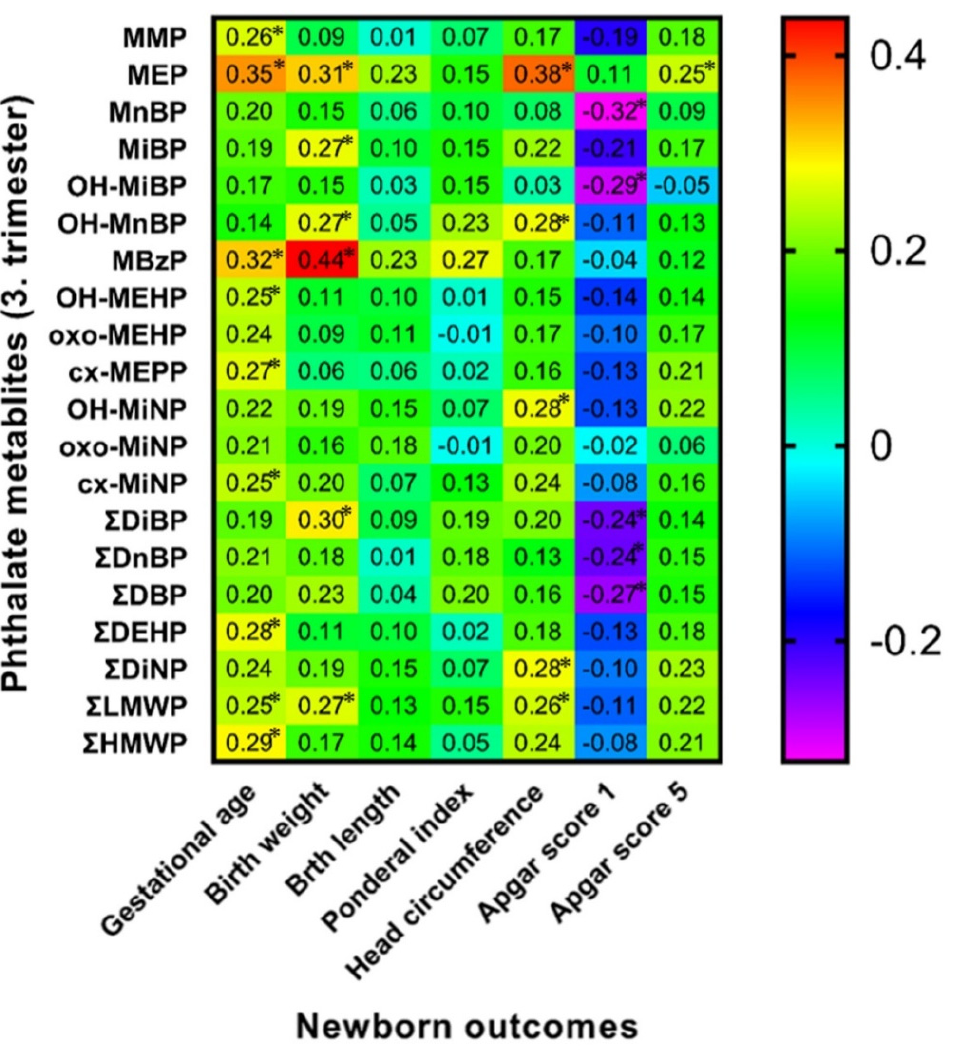
Figure 2. Correlation matrix of newborn outcomes and maternal phthalate metabolites during third trimester of pregnancy. Legend is shown in the footnote of Table 4. * The correlation is significant at the level p ≤ 0.05.